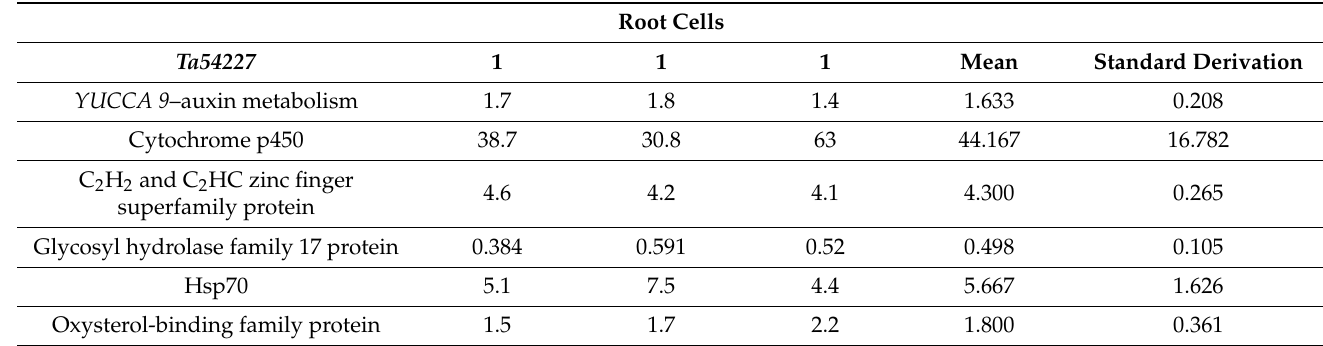
Table 4. The gene expression levels in the root